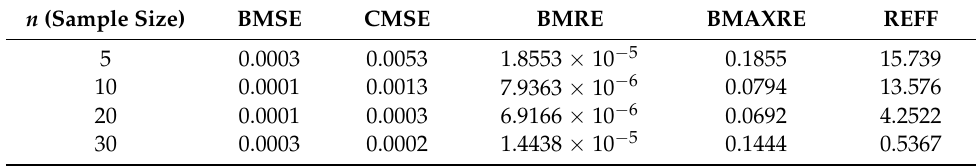
Table 10. Robustness: numerical results for case